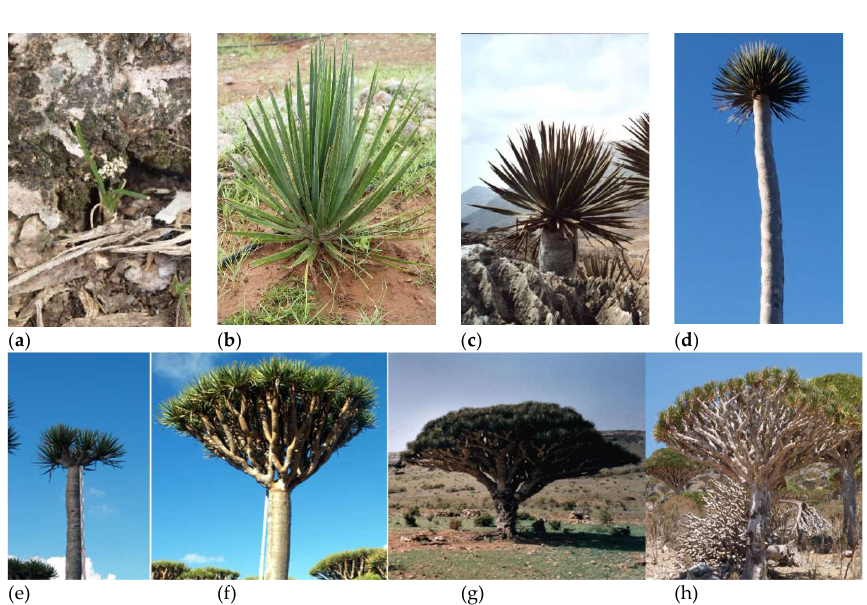
Figure 4. The vegetative phase (upper line of pictures) consists of seedling ( a ), early juvenile ( b ), medium juvenile ( c ) and late juvenile ( d ) stages. The generative phase (lower line of pictures) consists of early adult ( e ), fully adult ( f ), senescence ( g ) and senility ( h ) stages.